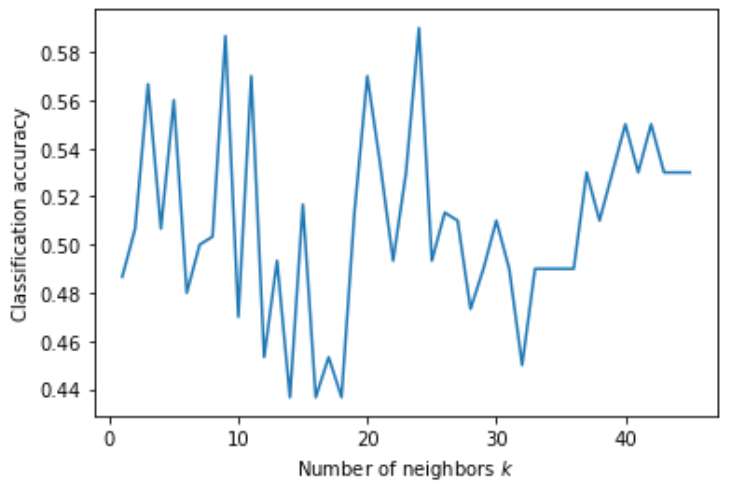
Figure 8. Classification accuracy according to k parameter of KNN on Dataset 06 when classification was based on